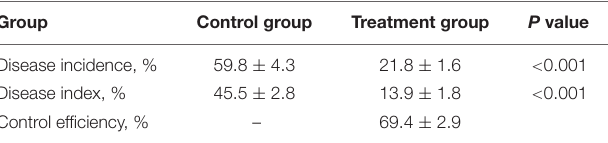
TABLE 1 | Statistics of disease rate, disease index, and control efficiency (day